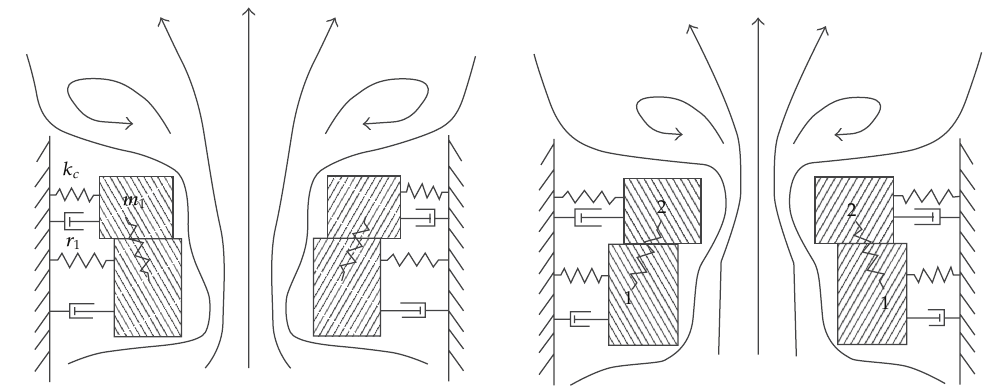
Figure 5: Air flow through glottis (cid:4) 21 (cid:5)